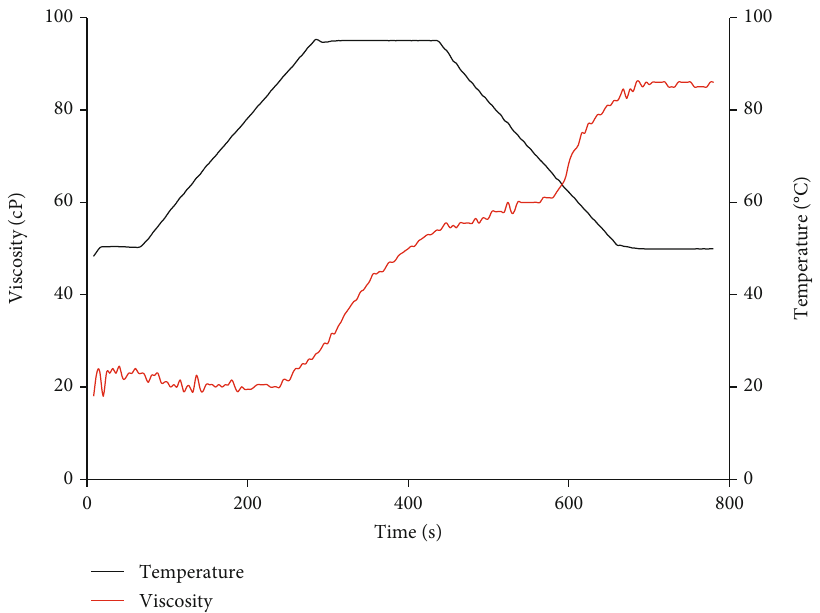
Figure 2: Viscosity pro fi le of formulated fl our under heating and